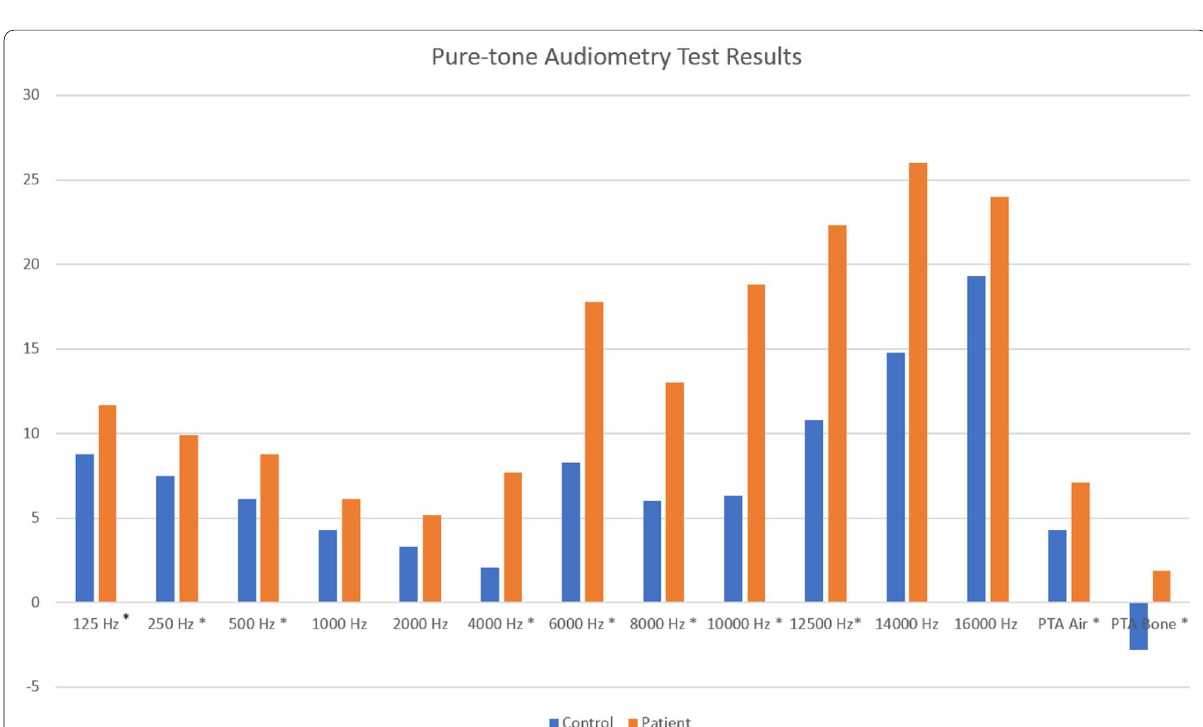
Fig. 1 Audiometric results of groups. Significant difference was observed in columns with asterisks [*] [ p < 0.05]